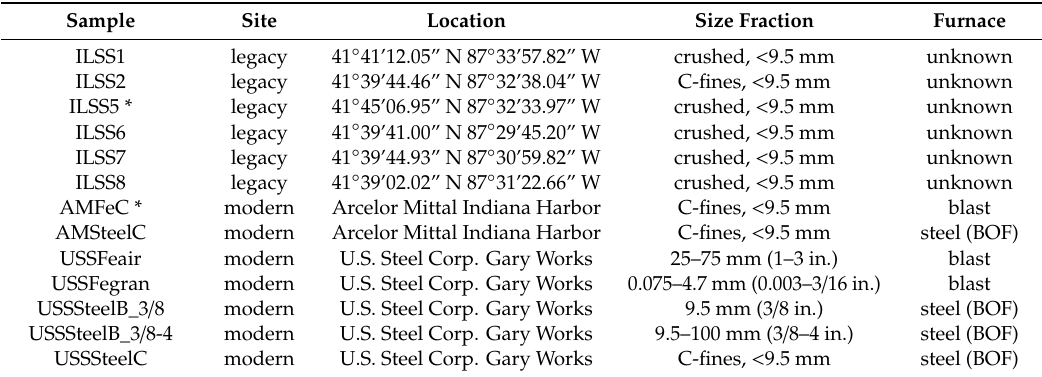
Table 1. Iron and steel slag samples from the Chicago-Gary area of Indiana and Illinois, USA. Latitude and longitude are given in degrees, minutes, and seconds for legacy sites. (BOF, basic oxygen furnace; ◦ , degree; ’, minute; ”, second; N, north; W, west; mm, millimeter; in., inches; < , less than; > , greater